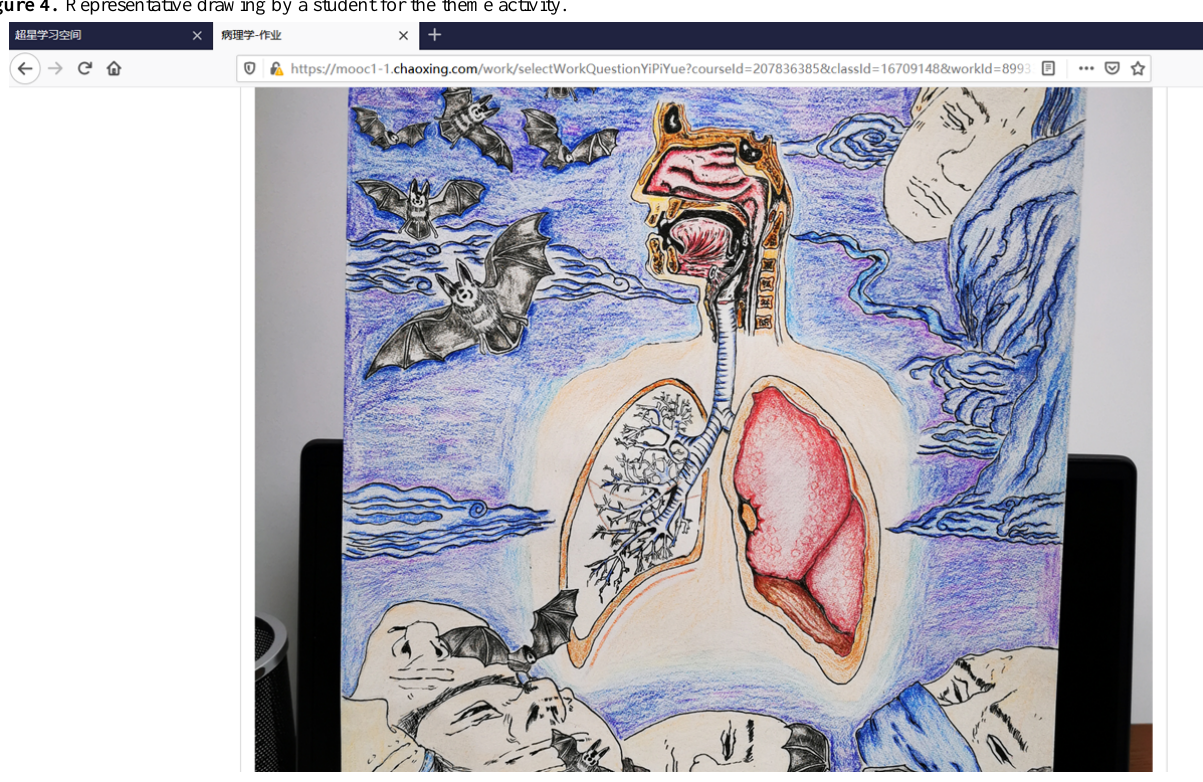
Figure 4. Representative drawing by a student for the theme